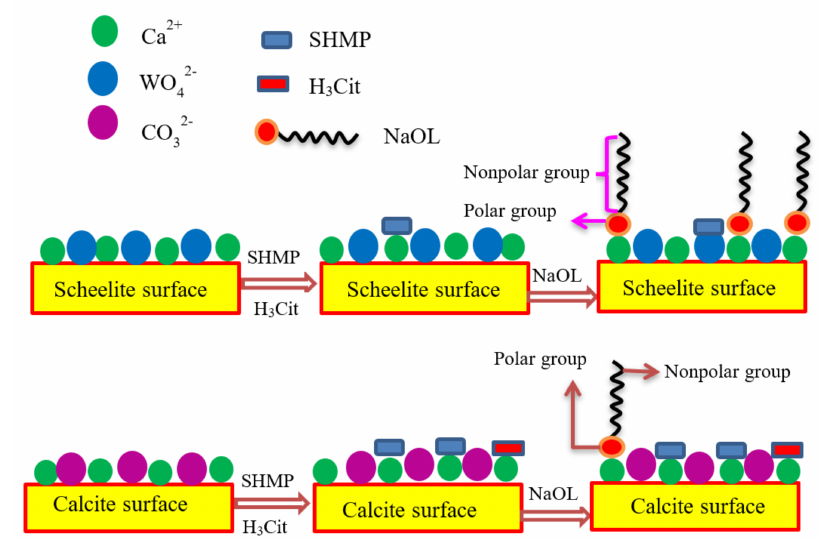
Figure 13. Schematic diagram of adsorption model of reagents on scheelite and